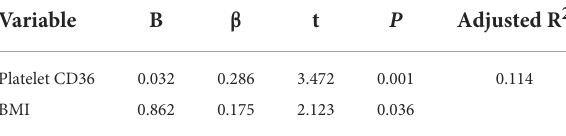
TABLE 2 Multiple linear regression analysis for risk factors of platelet activation in NVAF